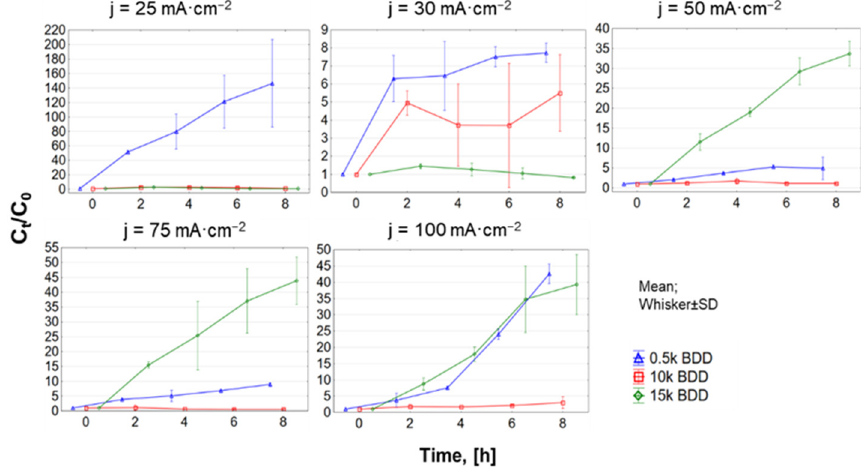
Figure A1. N-NO 3 − changes in LLs with different BDD anodes and current densities (25–100 mA·cm − 2 ).